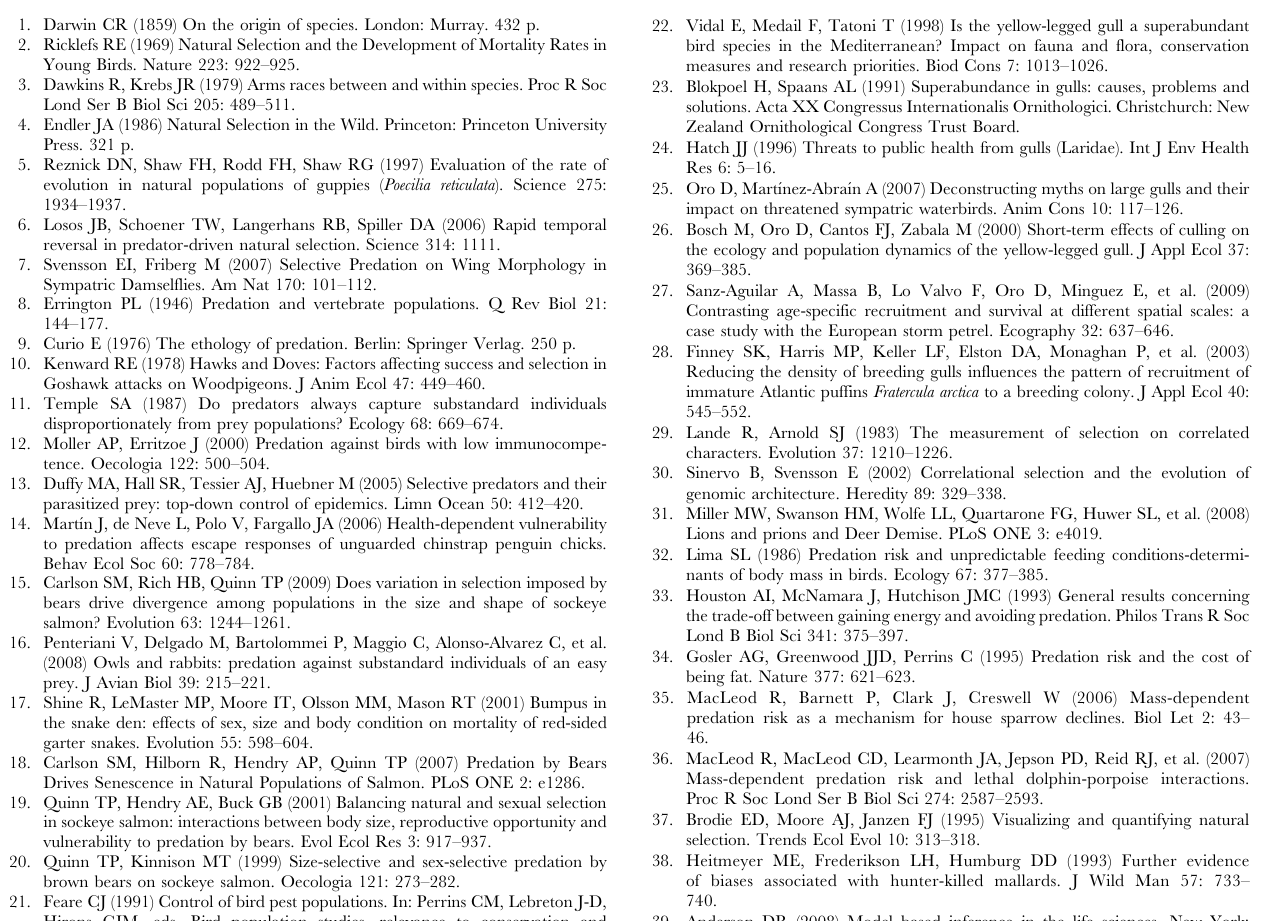
Table S1 Model selection of individual features of gulls predated by birds of prey compared to those shot at the